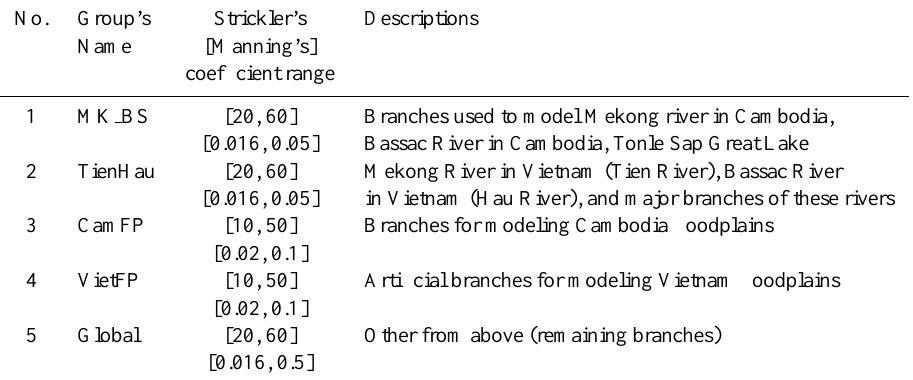
Table 3. Assignment of roughness values to five classes of channels and floodplains.